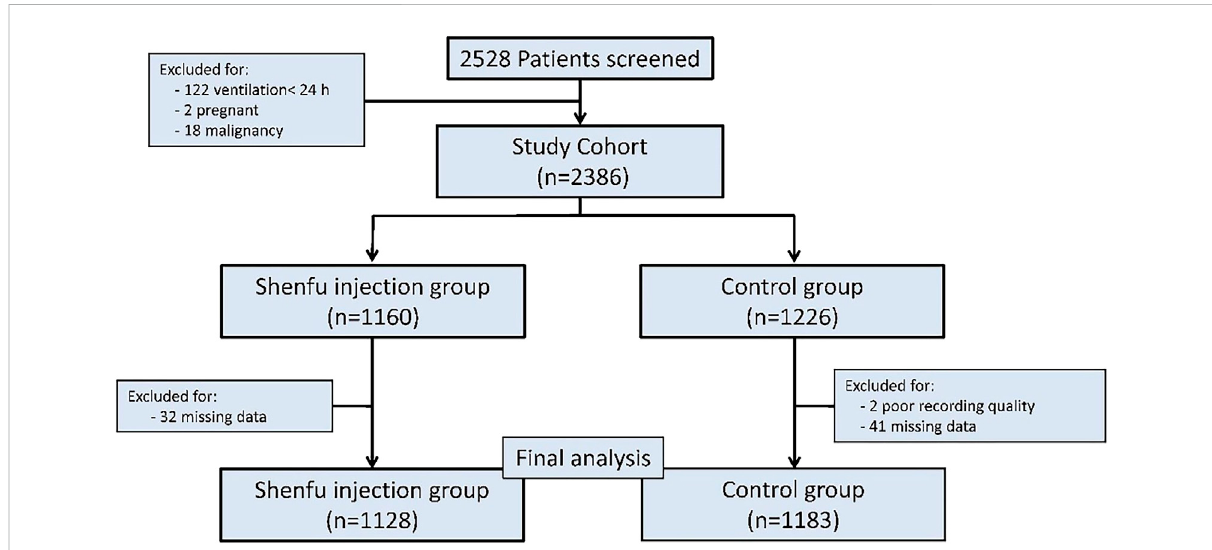
FIGURE 1 Study pro fi le: Study pro fi le for patients included in this study, and data cutoff was September